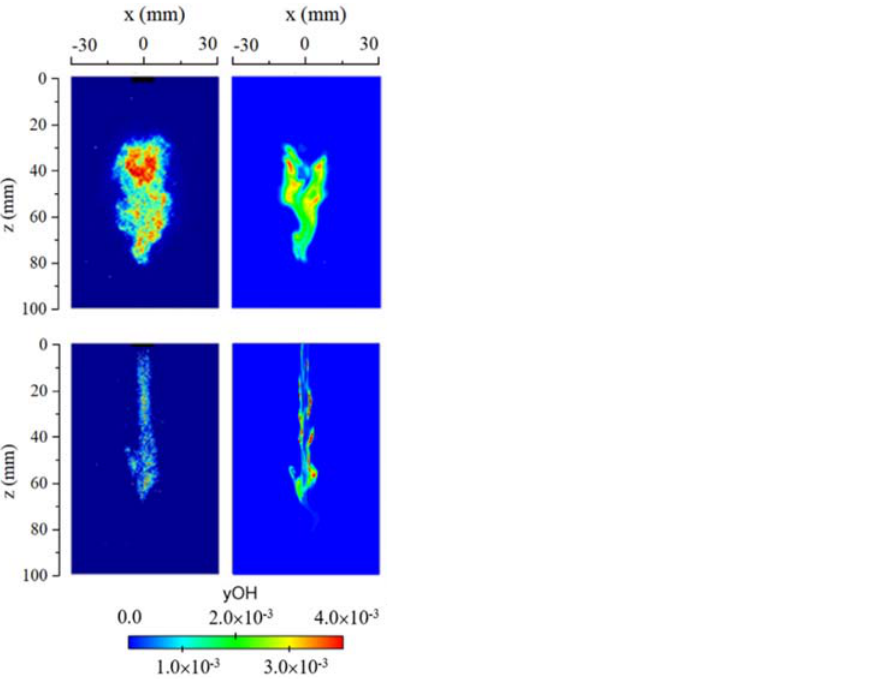
Figure 2. Comparison between the experimental results ( left ) and the simulation results ( right ).